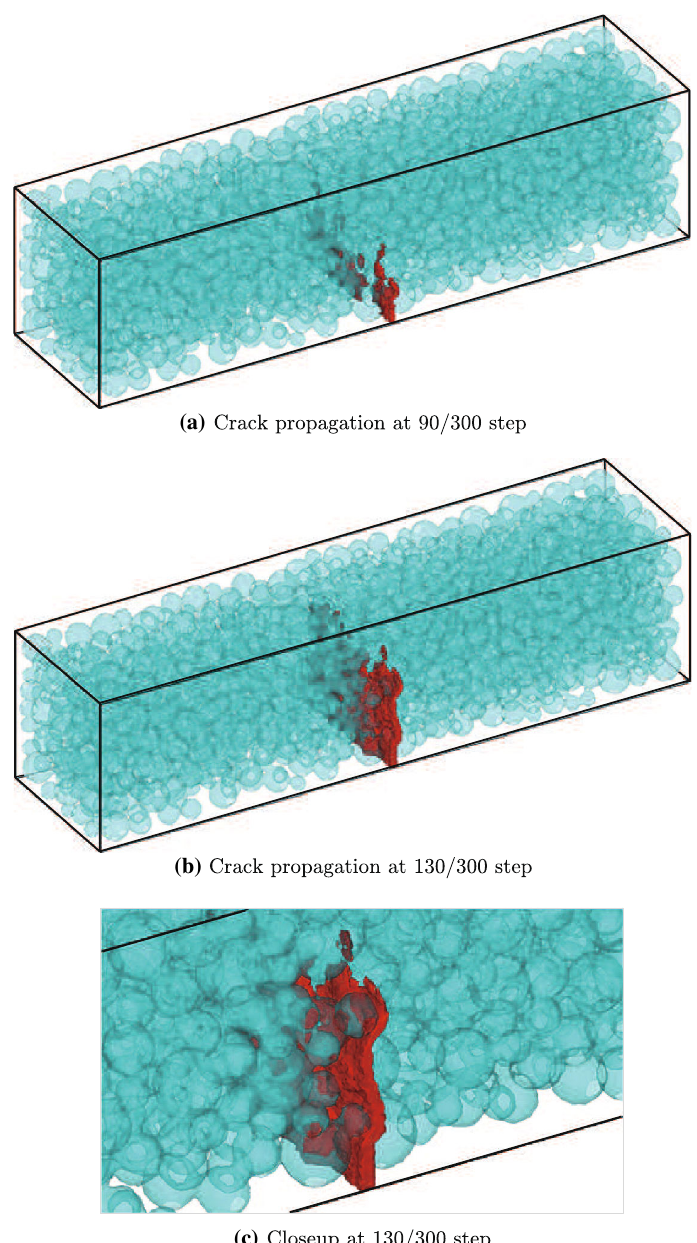
composite bar problems was first verified for a 1D problem. Then, a 2D problem was solved to verify the capability of evaluating the damage of the matrix-phase in composite materials. The numerical result also revealed that the proposed model allows the meshless finite element analysis of crack propagation behavior in multi-phase composite materials using the volume fraction of the matrix within the element, instead of generating a finite element mesh in accordance with the material interfaces. Finally, the proposed model was applied to the simulation of 3D cohesive crack growth in a heterogeneous solid with a large number of spherical inclusions, and the obtained results demonstrated that